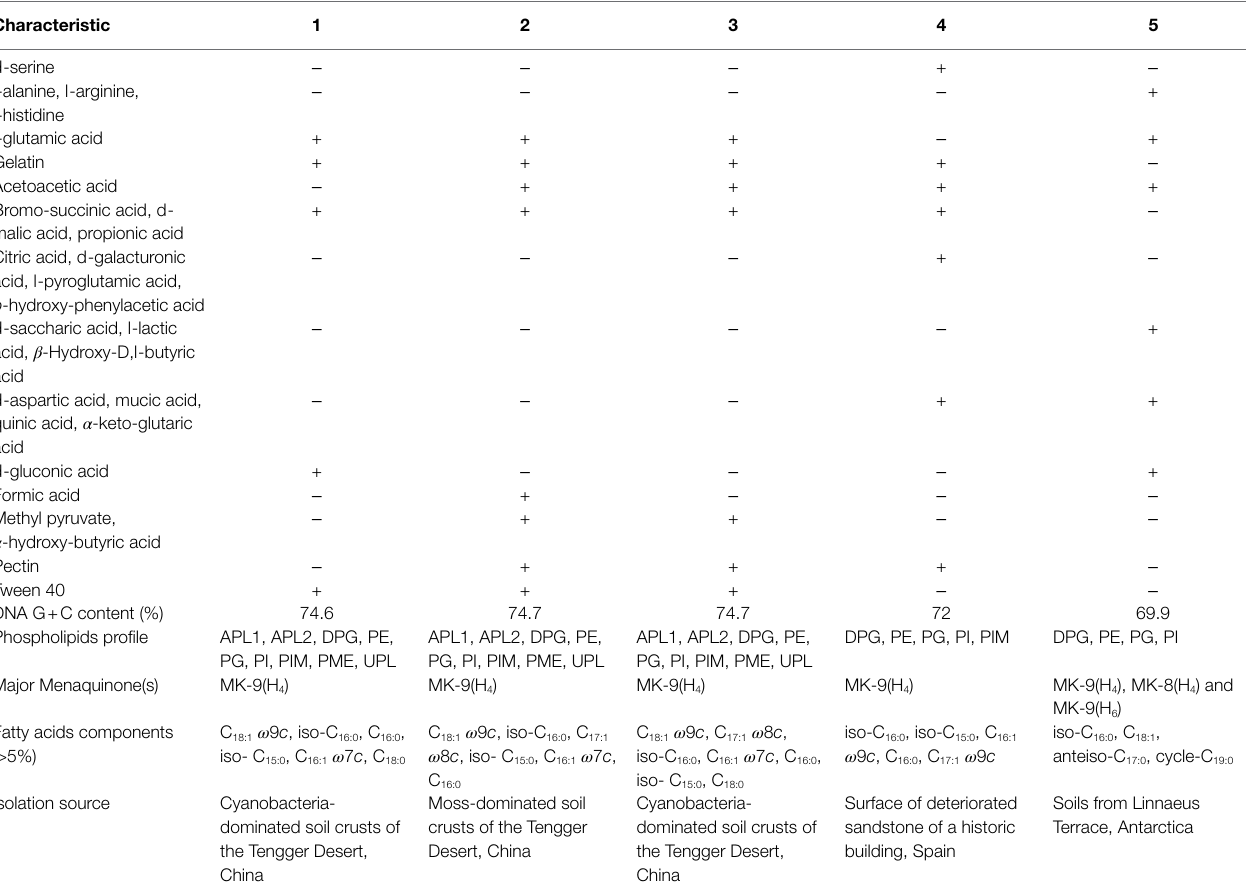
acid can be utilized as sole carbon sources in Biolog GEN III Micro-Plates. Acid is produced from esculin ferric citrate and potassium 5-ketogluconate. Cell wall contains alanine, glutamic acid, glycine and meso -diaminopimelic as diagnostic amino acids. The whole-cell hydrolysis contains arabinose, galactose, ribose and traces of glucose. The cellular polar lipid system includes DPG, PE, PG, PI, and PIM, as well as small amount of APL. The predominant respiratory quinone is MK-9(H 4 ), with minor of MK-8(H 4 ). The major fatty